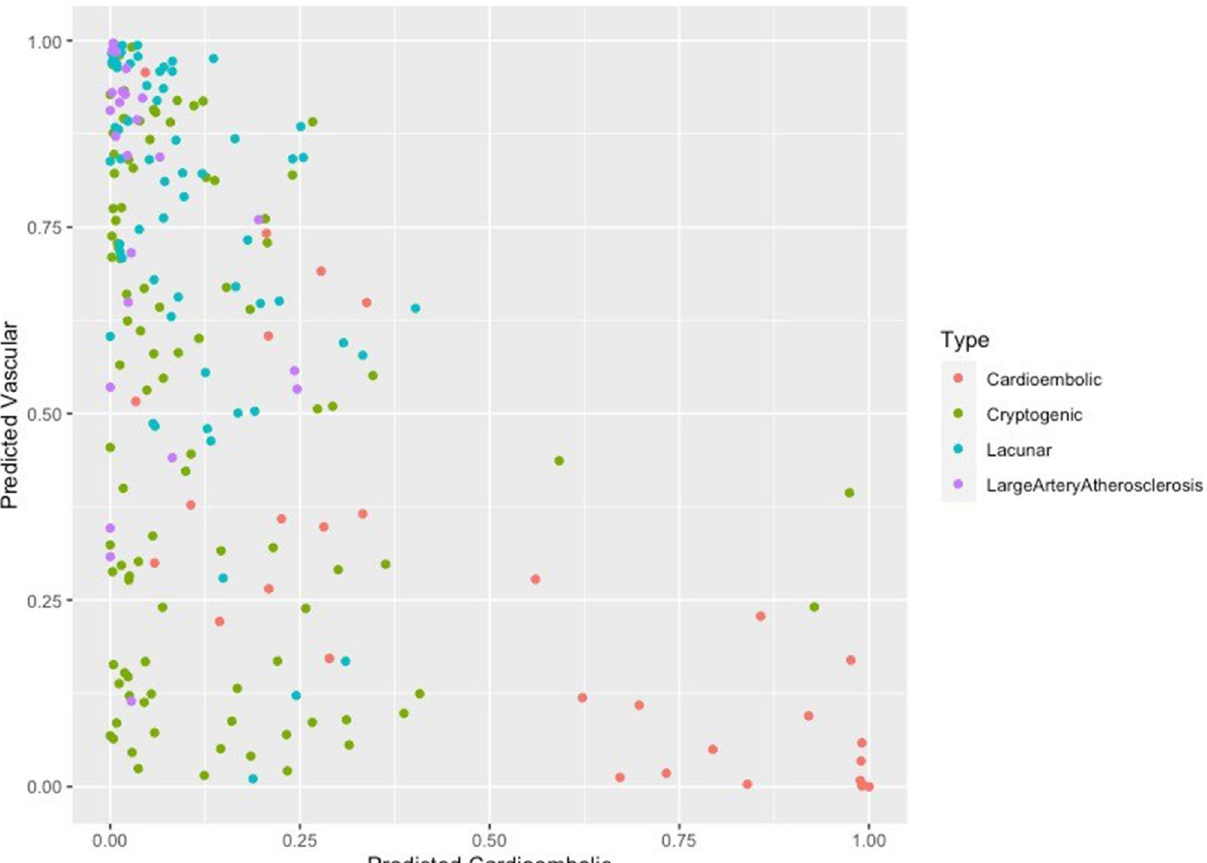
Figure 2. Stroke subtype cases plotted against probability that strokes would be classified as vascular or cardioembolic based on multivariate regression of CVD risk-factor